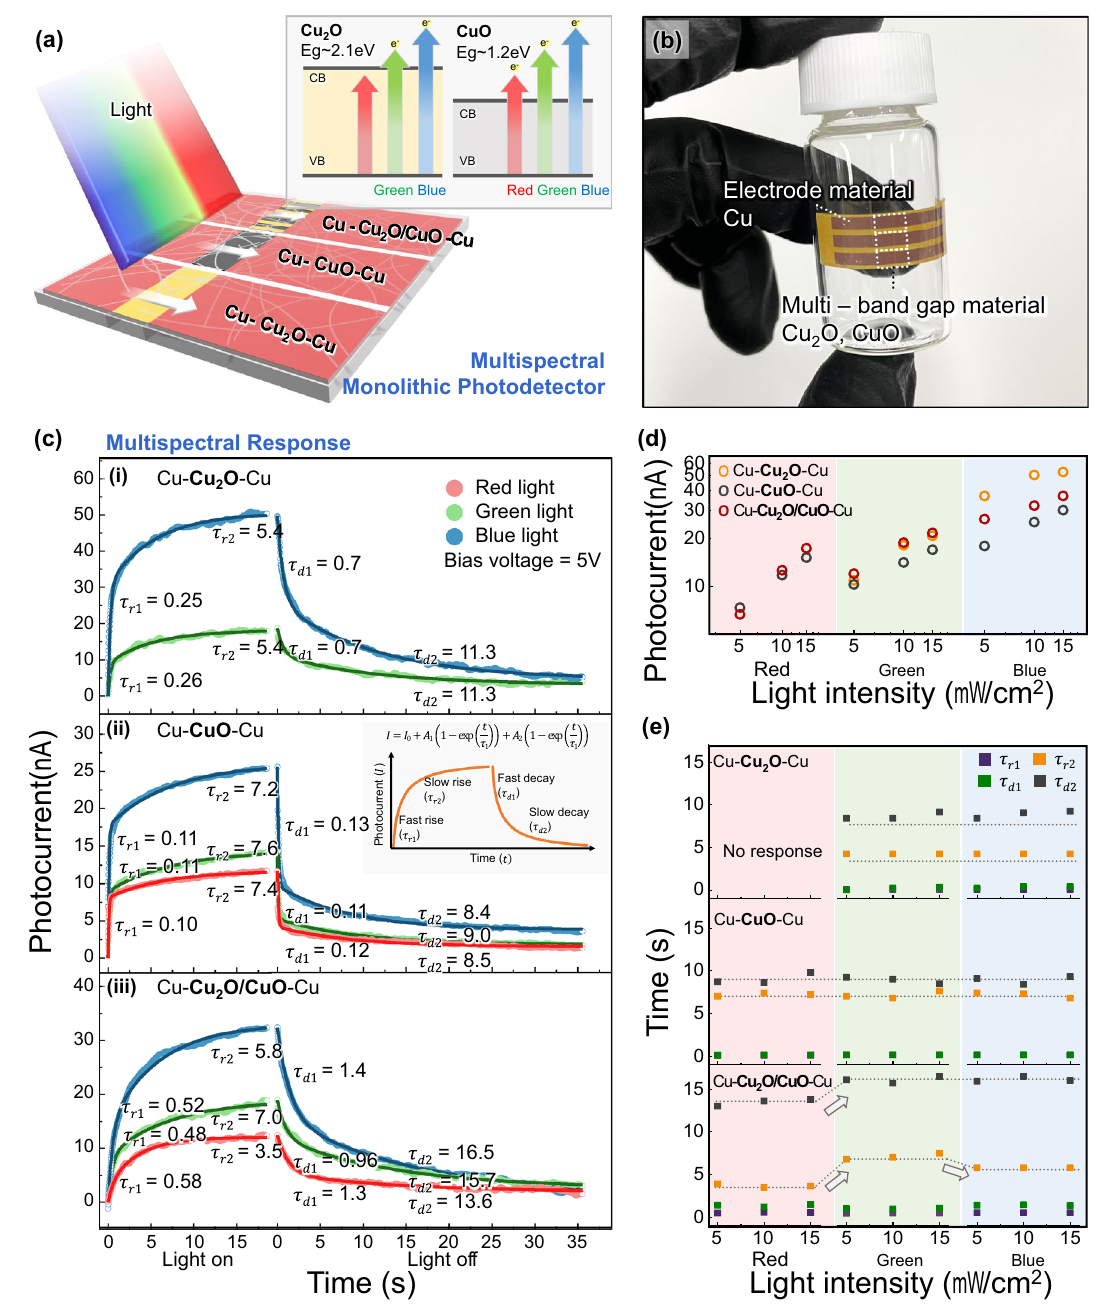
Fig. 4 a The schematic depicts monolithic integration for multispectral photodetectors. The schematic shows the different wavelength thresh- olds caused by the bandgap difference between Cu 2 O and CuO. b PUA-nanowire composite flexible photodetector: red color CuNW as electrode region, and a detecting channel between the two electrodes. c Photocurrent and time constant according to 10 mW cm −2 light on or off, the inset schematic presents fast and slow relaxation constants of bi-exponential relaxation. i The Cu–Cu 2 O–Cu photodetector. ii Cu–CuO–Cu photode- tector. iii Cu–Cu 2 O&CuO–Cu photodetector. d Log scale plot of the photocurrent magnitude at intensities of 5, 10, and 15 mW cm −2 for red (650 nm wavelength), green (532 nm wavelength), and blue light (450 nm wavelength). e Rise and decay constants at intensities of 5, 10, and 15 mW cm −2 for red (650 nm wavelength), green (532 nm wavelength), and blue light (450 nm